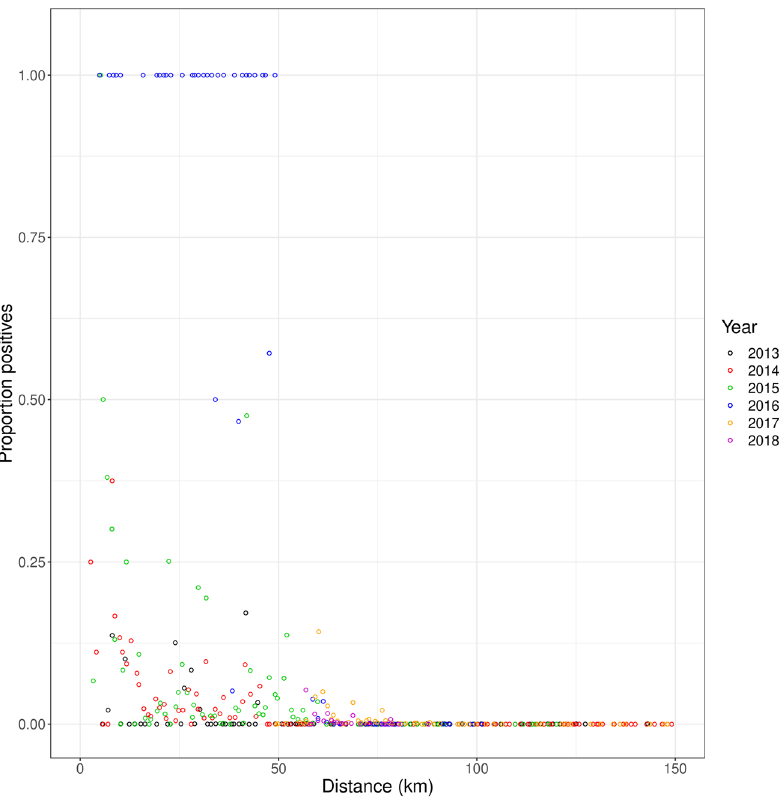
Figure 4. Relationship between proportion of positive samples per each km ring (Y-axis) and distance to Gallipoli (X-axis; km). Points with different colour represents different years.